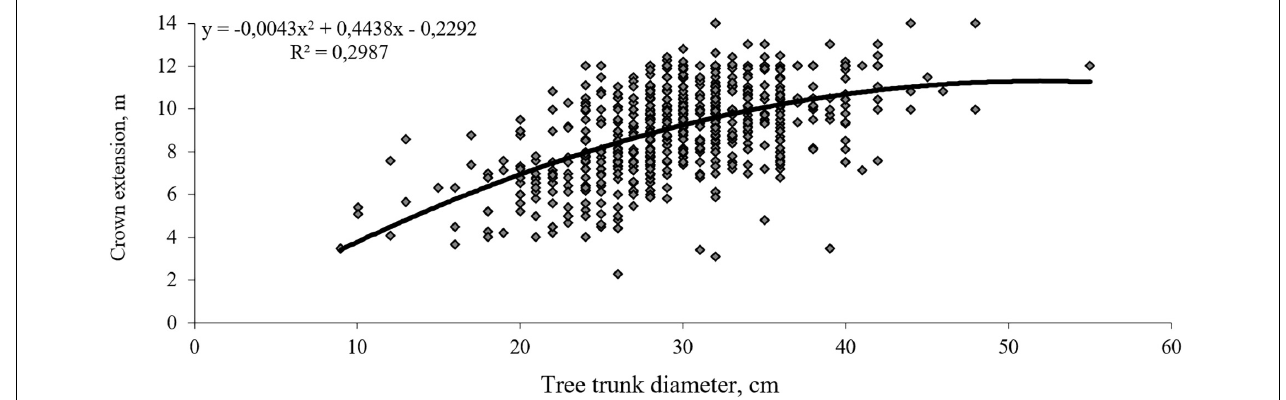
FIGURE 1 | Dependence of the crown extension on the linden trunk diameter (41–60 years